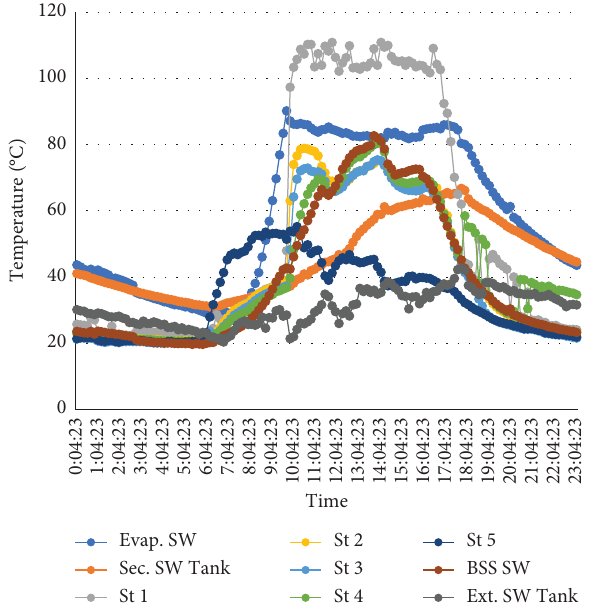
Figure 14: SW temperature in the condensing tower under high average conditions (13 Jan